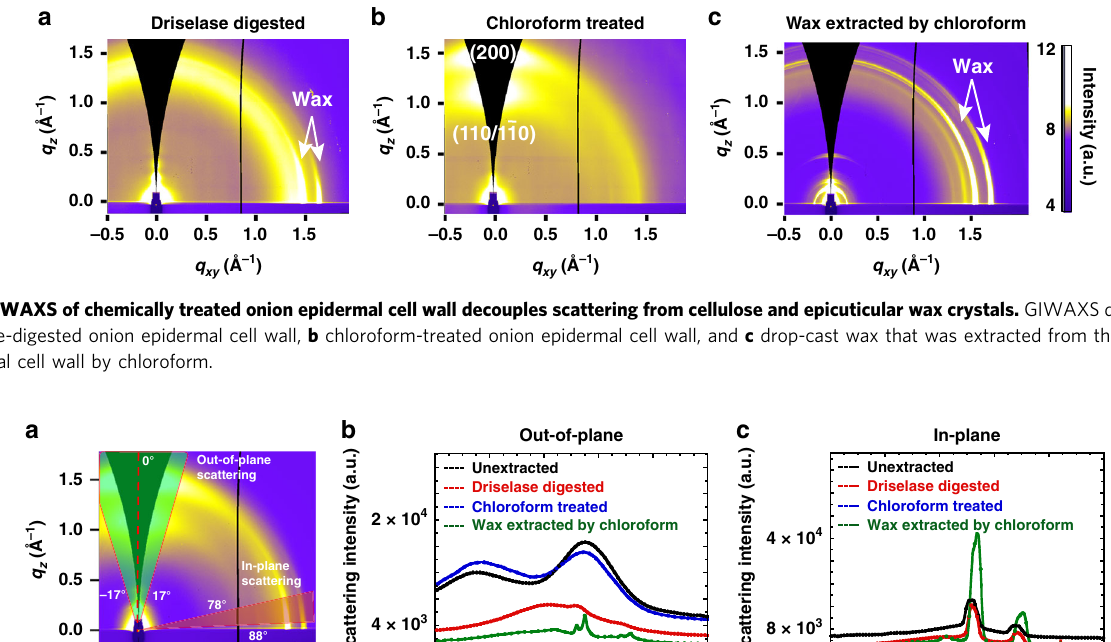
Fig. 3 Differences in GIWAXS out-of-plane and in-plane scattering pro fi les and peak locations suggest multiple diffracting species. a Reduced GIWAXS pro fi les are obtained by azimuthally integrating over a sector from − 17° to + 17° (area highlighted in green) along the out-of-plane direction and from 78° to 88° (area highlighted in red) along the in-plane direction. b , c GIWAXS pro fi les derived from onion epidermal cell walls with different treatments (unextracted: black, Driselase digested: red, chloroform treated: blue, wax extracted by chloroform: green) obtained from sector averages along the b out-of-plane direction (sector average from − 17° to + 17°) and c in-plane direction (sector average from 78° to 88°).